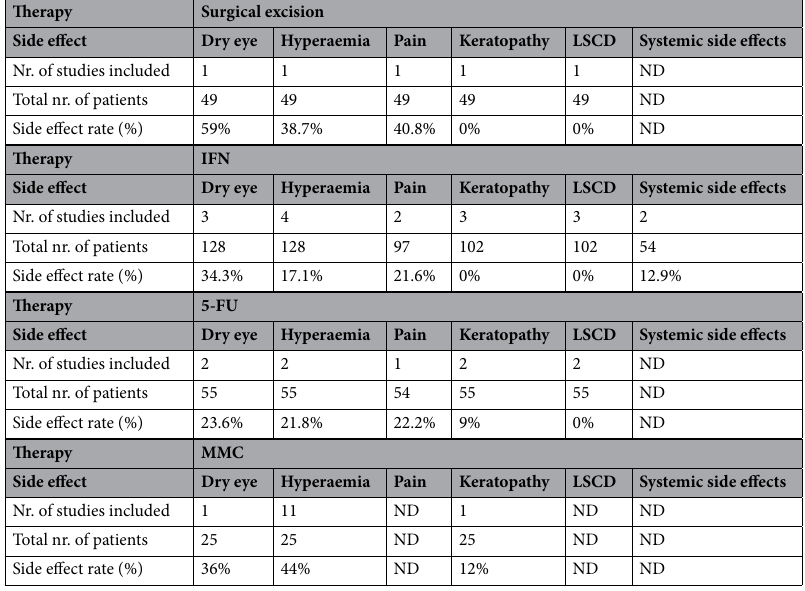
Table 4. Complications and side effects of different treatment modalities. LSCD limbal stem cell